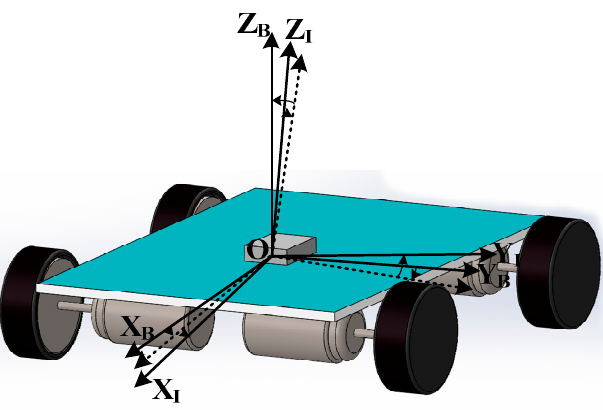
Figure 3. IMU and mobile car installation model.